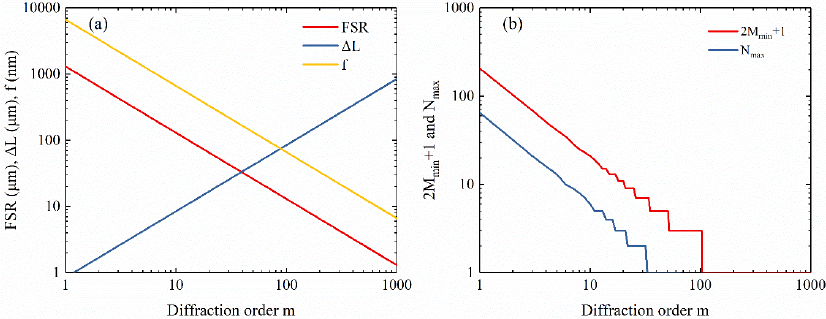
Figure 1. ( a ) Relations between the diffraction order m and the length difference of adjacent arrayed waveguides Δ L , focal length of slabs f, and FSR. ( b ) Relations between the diffraction order m and the maximum number of I/O channels Nmax and the minimum number of arrayed waveguides 2 M min + 1. Table 1. Design parameters of 5 × 5 arrayed waveguide grating (AWG) .